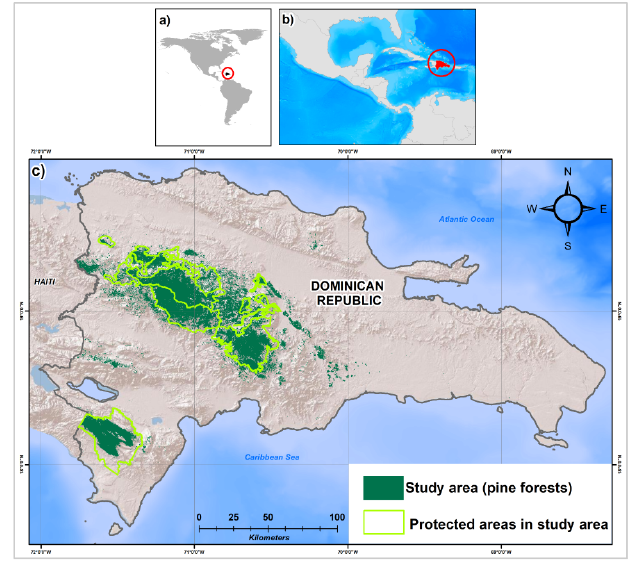
Figure 1. Study area ( a ) general location of the Dominican Republic, ( b ) regional location, and ( c ) study area including the protected areas.